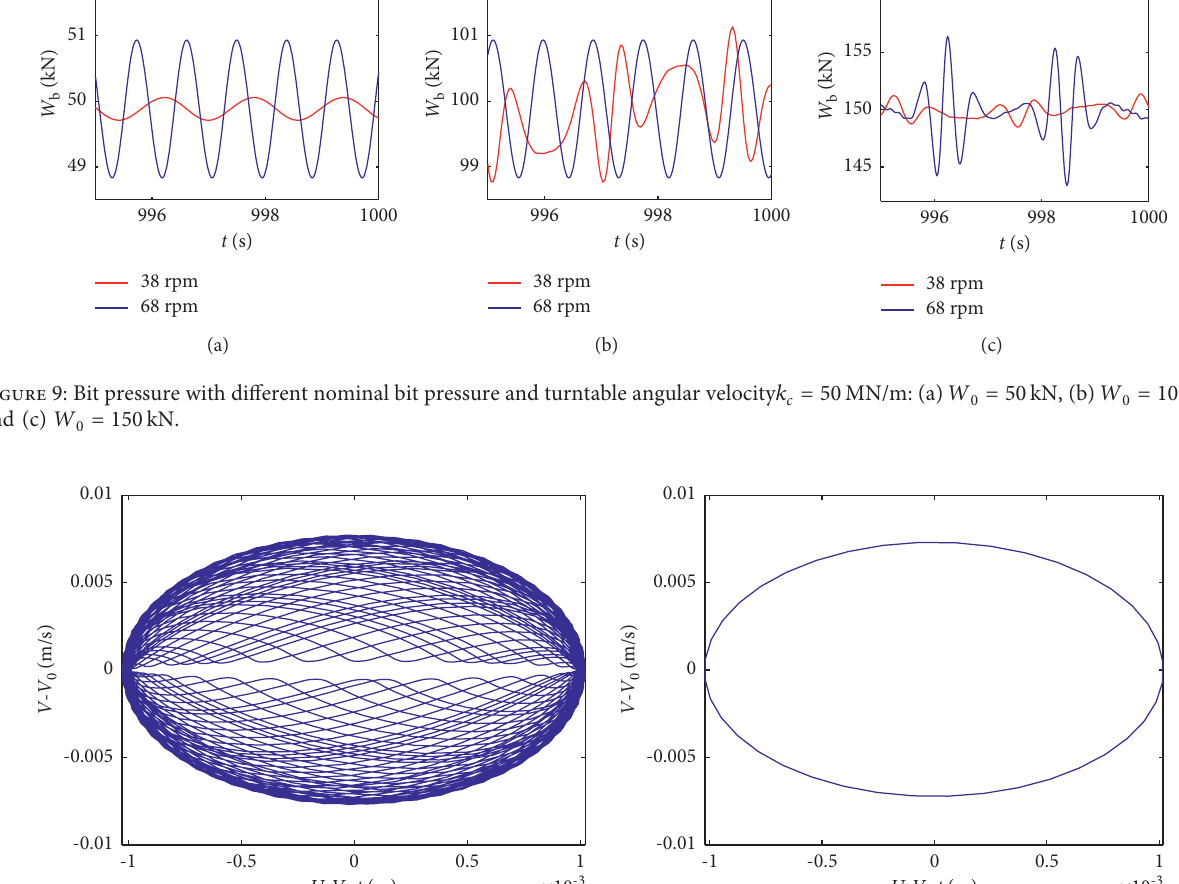
Figure 8: Time process with different nominal drilling pressure and.angular velocity of turntable drive, k displacement of axial vibration and (b) relative angular velocity of torsional vibration.